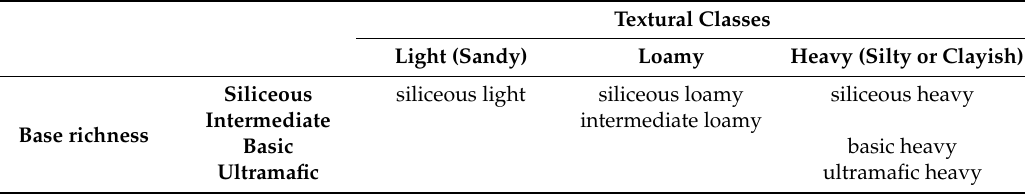
Table A1. Potential richness-textural classes used to classify soil parent